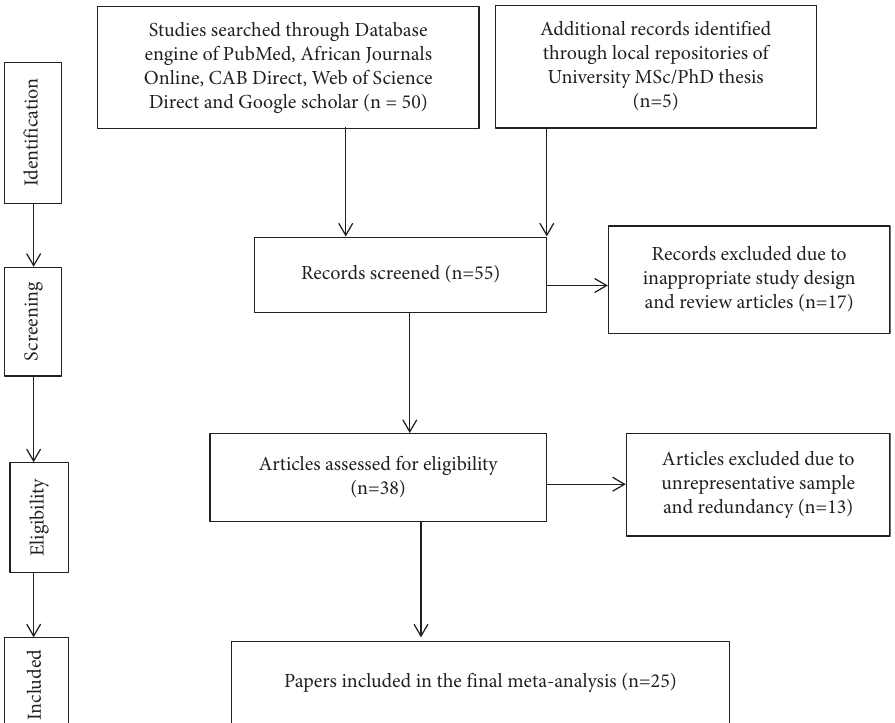
Figure 1: Schematic representation of the literature selection procedure for the systematic review of calf mortality prevalence in Ethiopia that depicts excluded and included